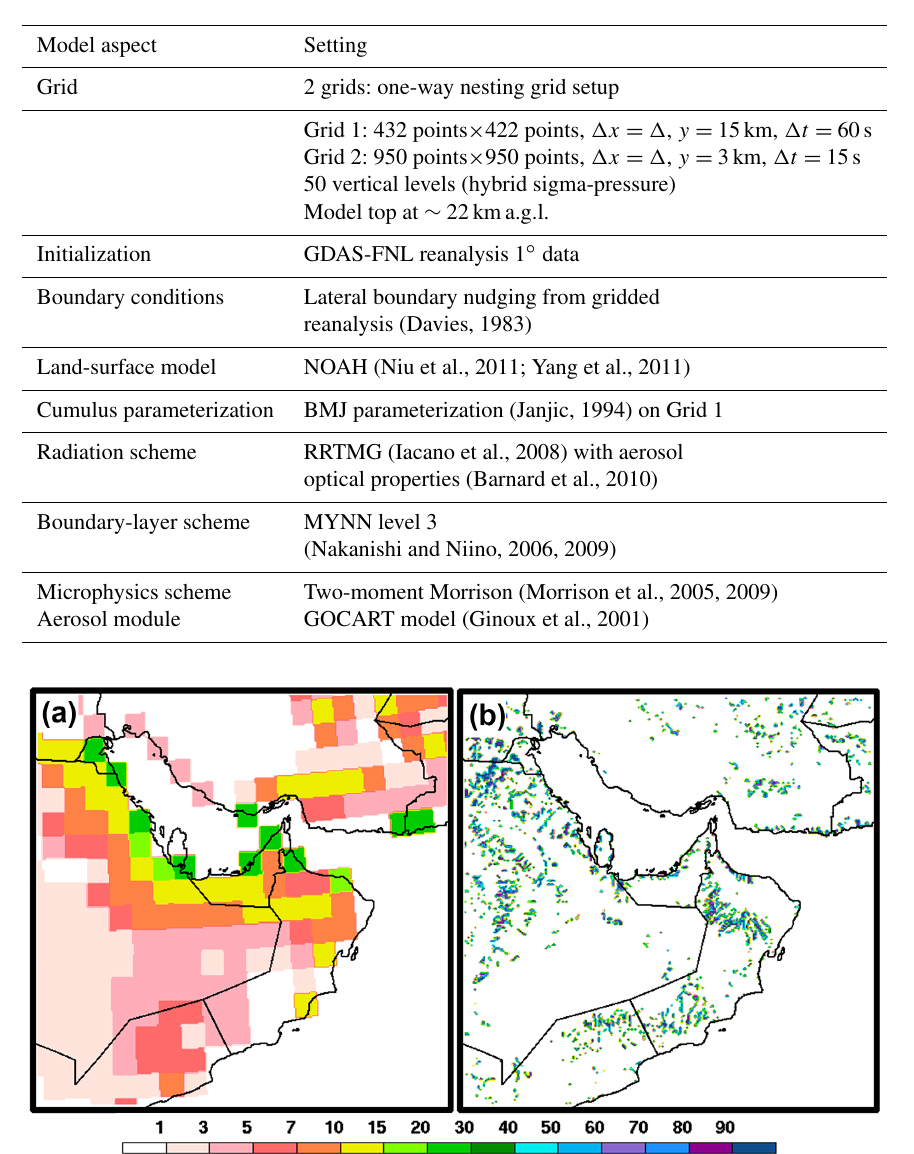
Table 2. Summary of WRF-Chem model grid setup and simulation configuration.